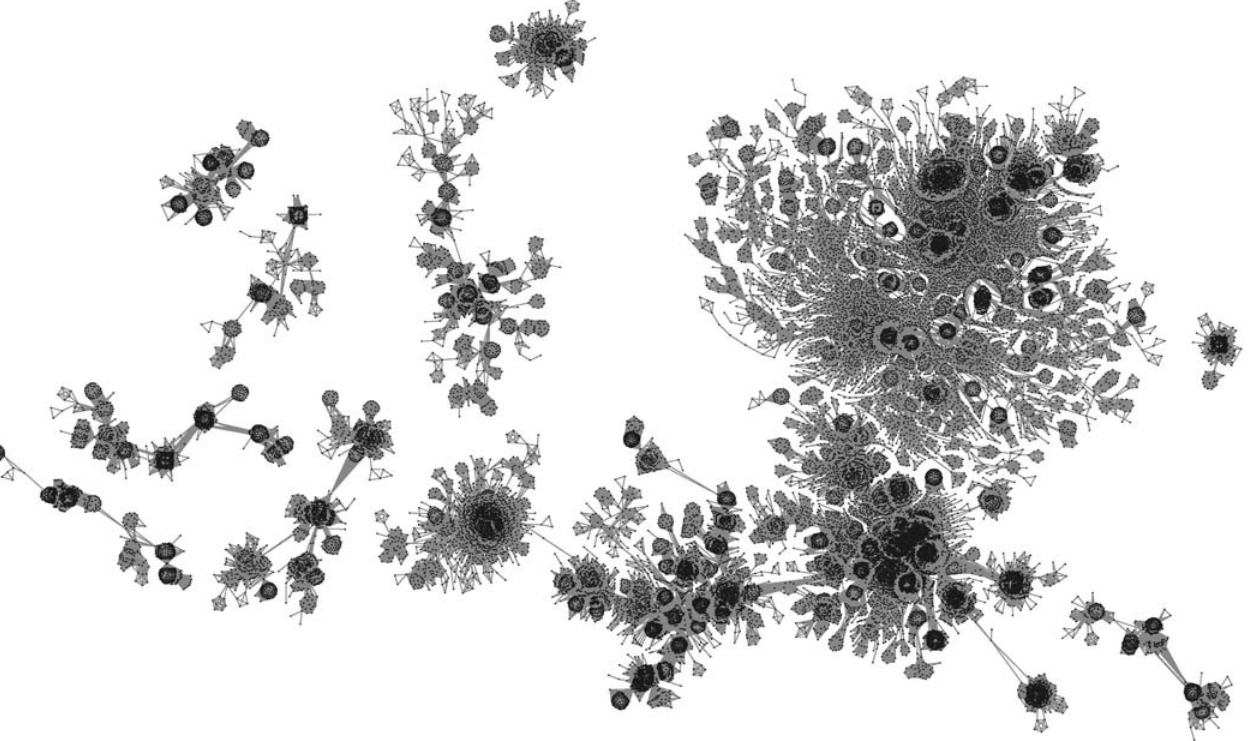
Figure 2. The Protein Homology Network A representation of a few of the largest connected components of the PHN for e ¼ 10 (cid:1) 30 (39,321 nodes, 4.4 3 10 6 links, see Protocol S1). Points represent proteins, and links represent sequence homology relationships with a BLAST E-value smaller than e . The modular structure of the PHN is clearly visible in the figure, where many tightly connected groups of proteins appear to be linked together to form globally sparse connected components. By increasing the value of e , the number of links wiring the network grows, causing many smaller components to coalesce into a single giant cluster. Moreover, many of the sparse points of the figure, which appear not to belong to any compact cluster, also join some compact region, increasing the network modularity.